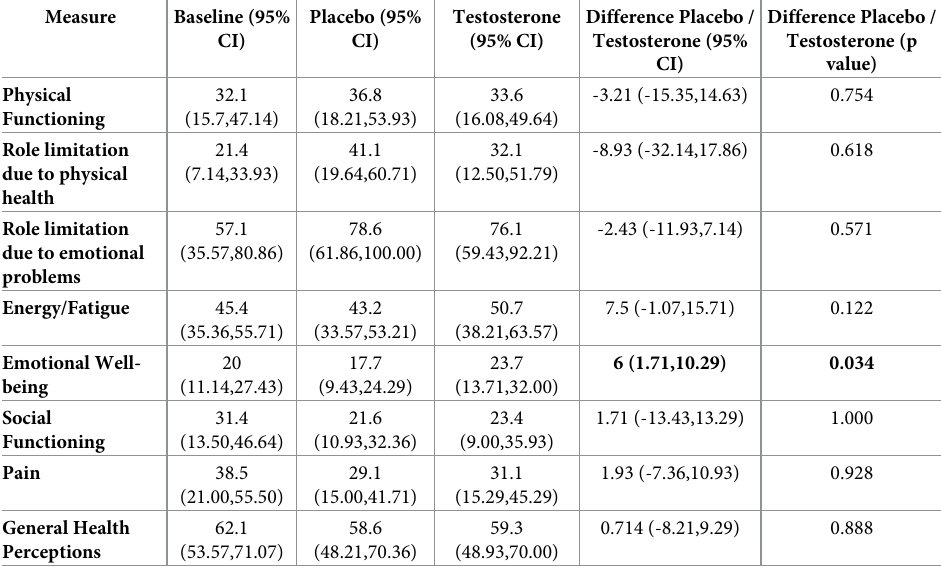
Table 4. Comparison of the RAND-SF-36 and IBM-FRS testosterone and placebo